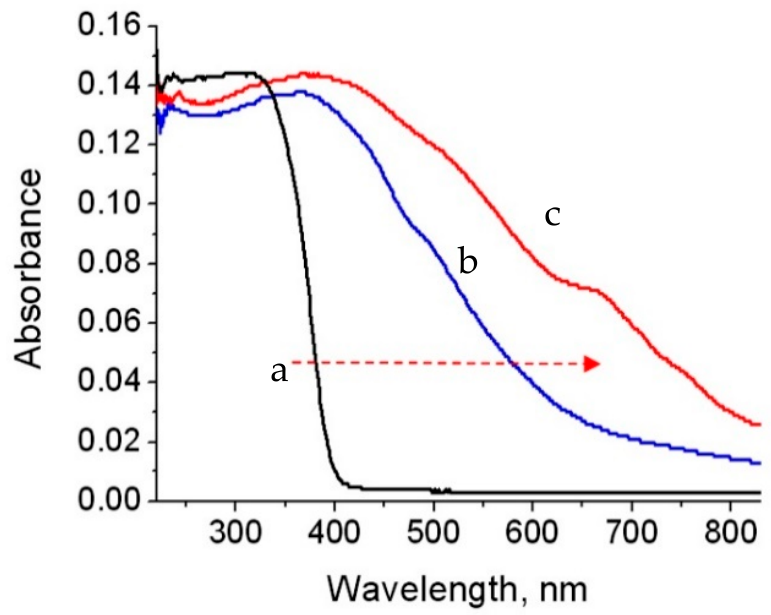
Figure 7. UV–Vis absorbance of: ( a ) BT nano commercial, ( b ) BT2-900 and ( c ) BT1-900.